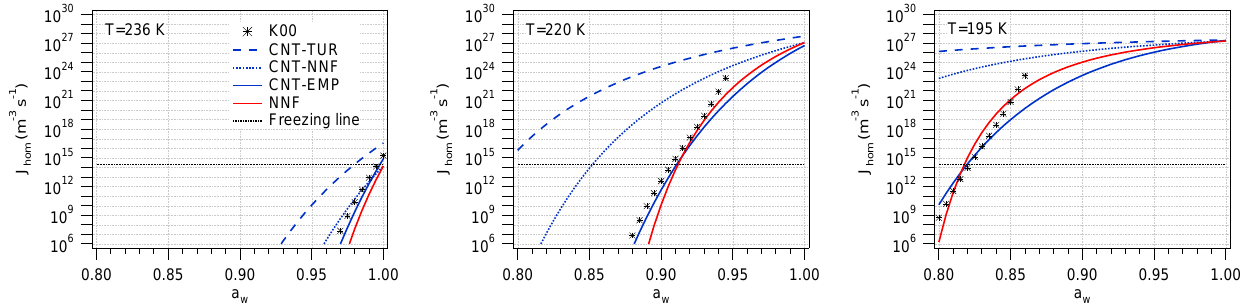
Figure 4. Homogeneous nucleation rate. K00 and NNF correspond to J hom obtained using the correlations of Koop et al. (2000) and the NNF model (Eq. 19) respectively. For CNT σ iw was calculated using the Turnbull (1950) correlation (CNT-TUR, Eq. 25), an empirical correlation derived from fitting CNT to the K00 parameterization (CNT-EMP, Eq. 29), and a theoretical expression derived from the NNF model (CNT-NNF, Eq. 27).